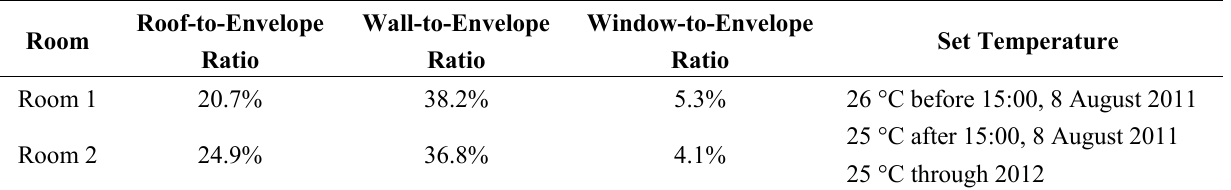
Table 1. Characteristics of objective rooms.